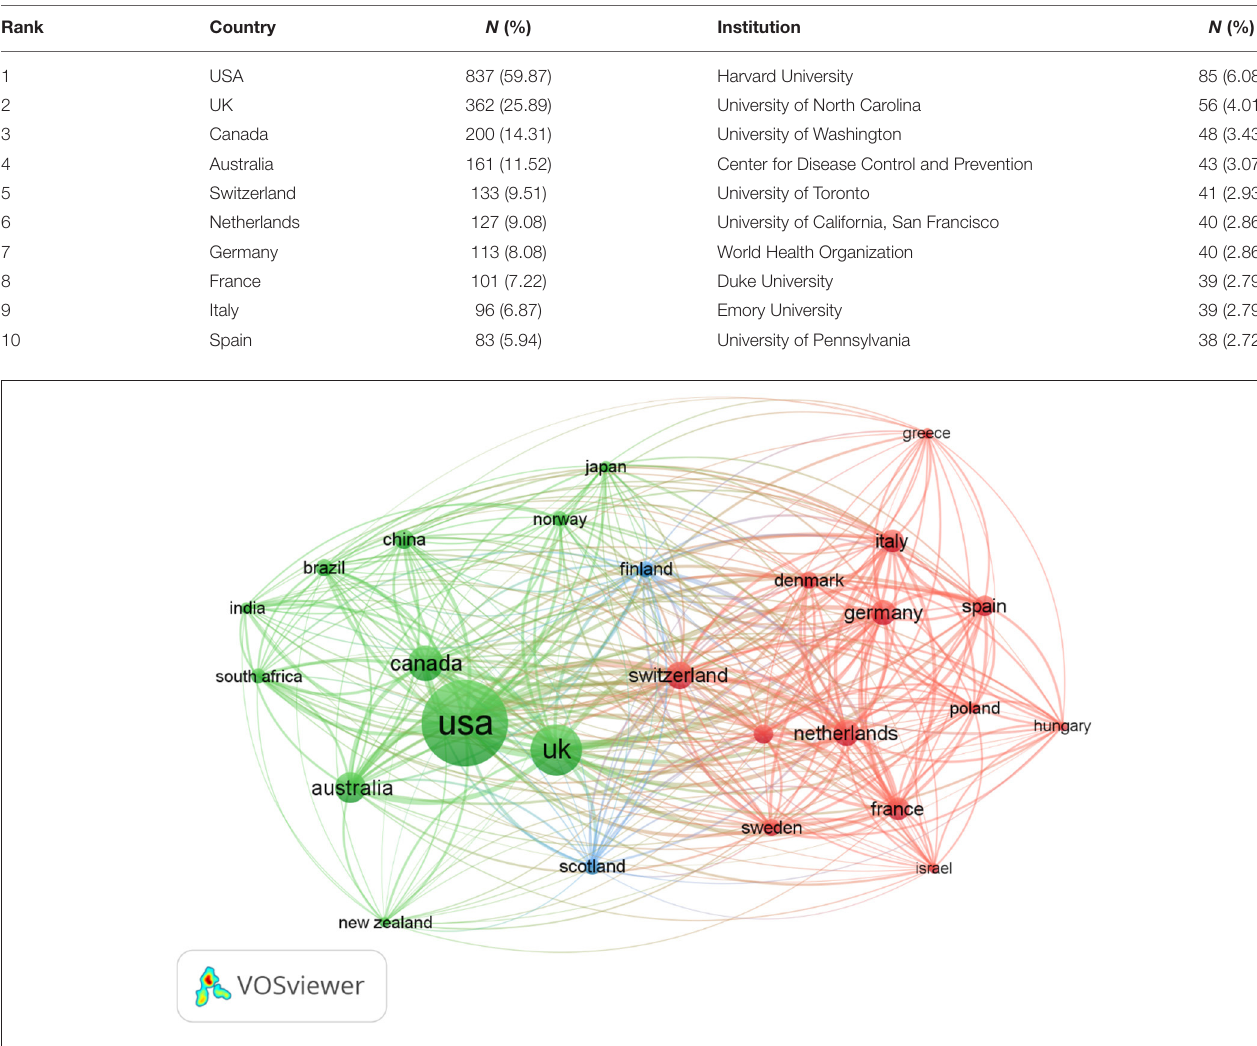
FIGURE 2 | The network map of countries.